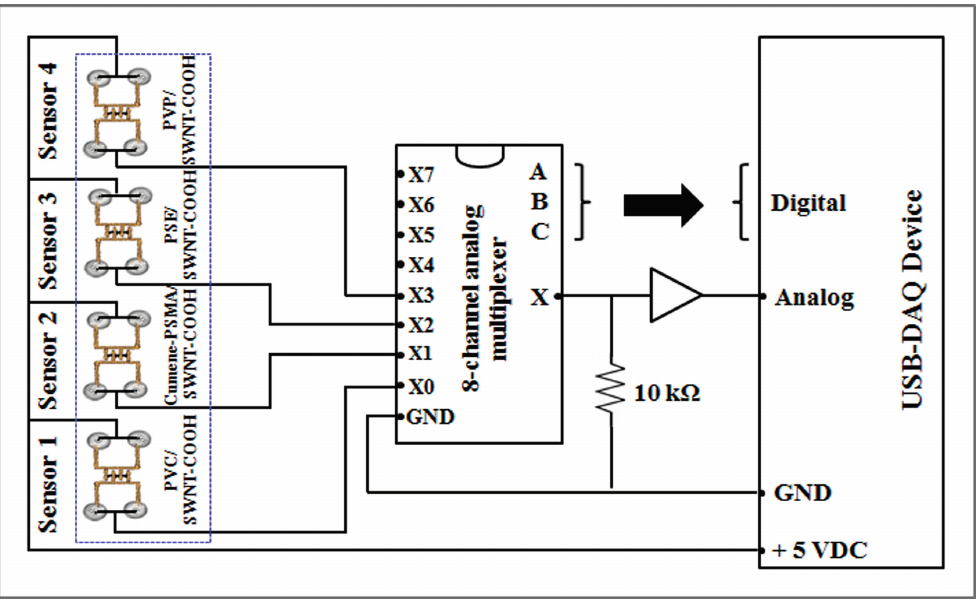
Figure 6. Schematic circuit diagram of data acquisition for the fabric-based